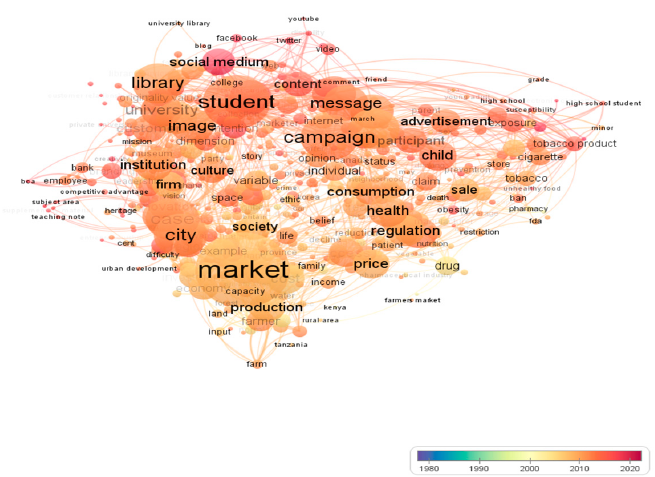
Figure 9. Main areas networking, time series (2006–2014). Source: authors using VOSviewer software.